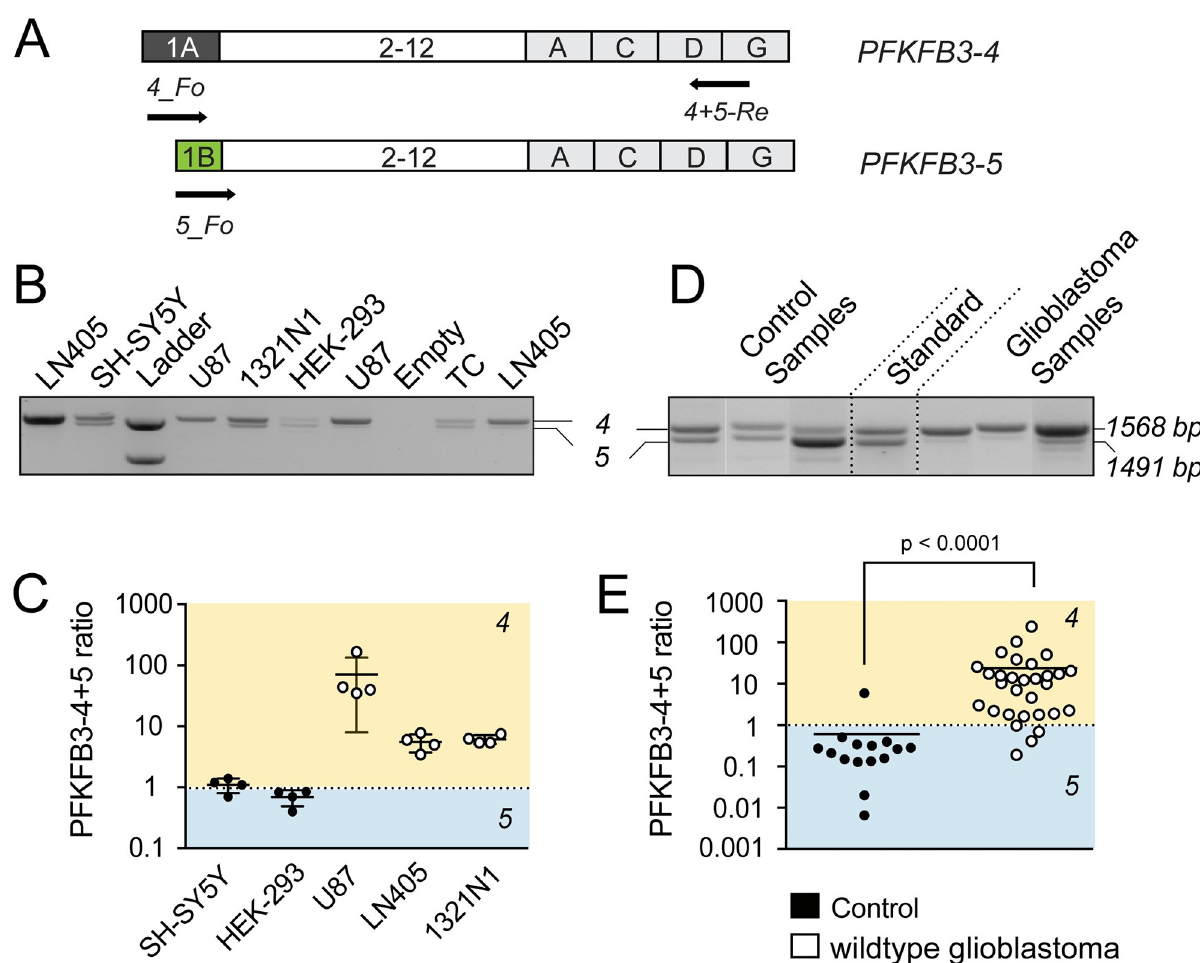
Fig 7. Glioblastoma cell lines and wildtype glioblastomas are signified by high PFKFB3-4 to PFKFB3-5 ratio. (A) Schematic illustration of experimental design of multiplex PCR used to measure the PFKFB3-4 to PFKFB3-5 mRNA ratio in different cell lines (B,C) and brain samples from patients (D,E). (B) Multiplex PCR products from several cell lines and human temporal cortex (TC) were separated by agarose gel electrophoresis. Equal amounts of mRNA of PFKFB3-4 and PFKFB3-5 (10 7 copies) were used as a standard (1568 bp and 1491 bp). (C) Scatter dot blot of PFKFB3-4 to PFKFB-5 mRNA ratios calculated from fluorescence intensities of PFKFB3-4 (1568 bp) and PFKFB3-5 (1491 bp) fragments (n = 4). (D) Agarose gel electrophorese of multiplex PCR products from three representative normal tissue as control samples and three IDH-wildtype glioblastomas. Equal amounts of mRNA from PFKFB3-4 and PFKFB3-5 (10 7 copies) were used as a standard. (E) Fluorescence intensities of multiplexed PCR fragments from 15 control and 30 samples from IDH-wildtype glioblastoma patients were used to quantify the ratio of PFKFB3-4 to PFKFB3-5 . Similar to cell lines, fast-proliferating glioblastoma samples from patients tend to show higher PFKFB3-4 expression. All groups were compared using the Mann Whitney test.